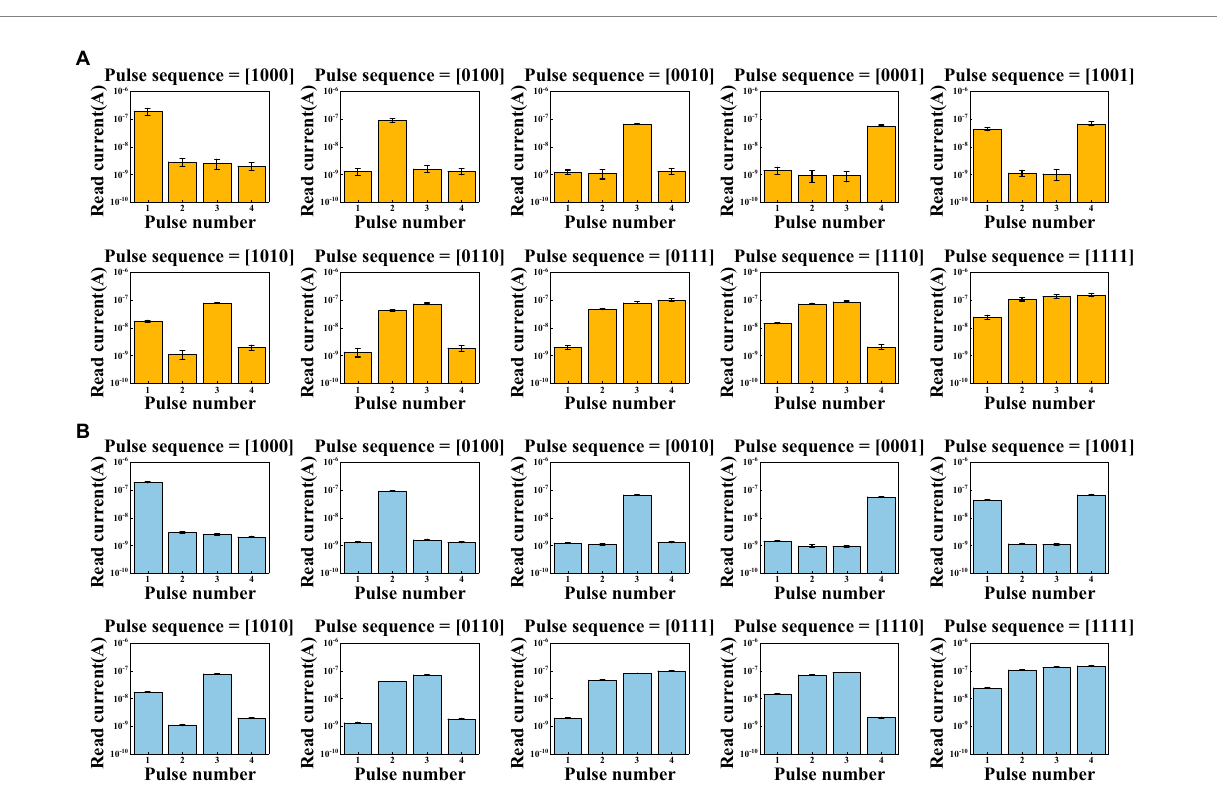
FIGURE 5 Evolutions of the mean currents passing through a memristor upon receiving trains of pulses with different possible patterns, where (A) error bars are standard deviations, (B) error bars are standard errors of the means, over 30